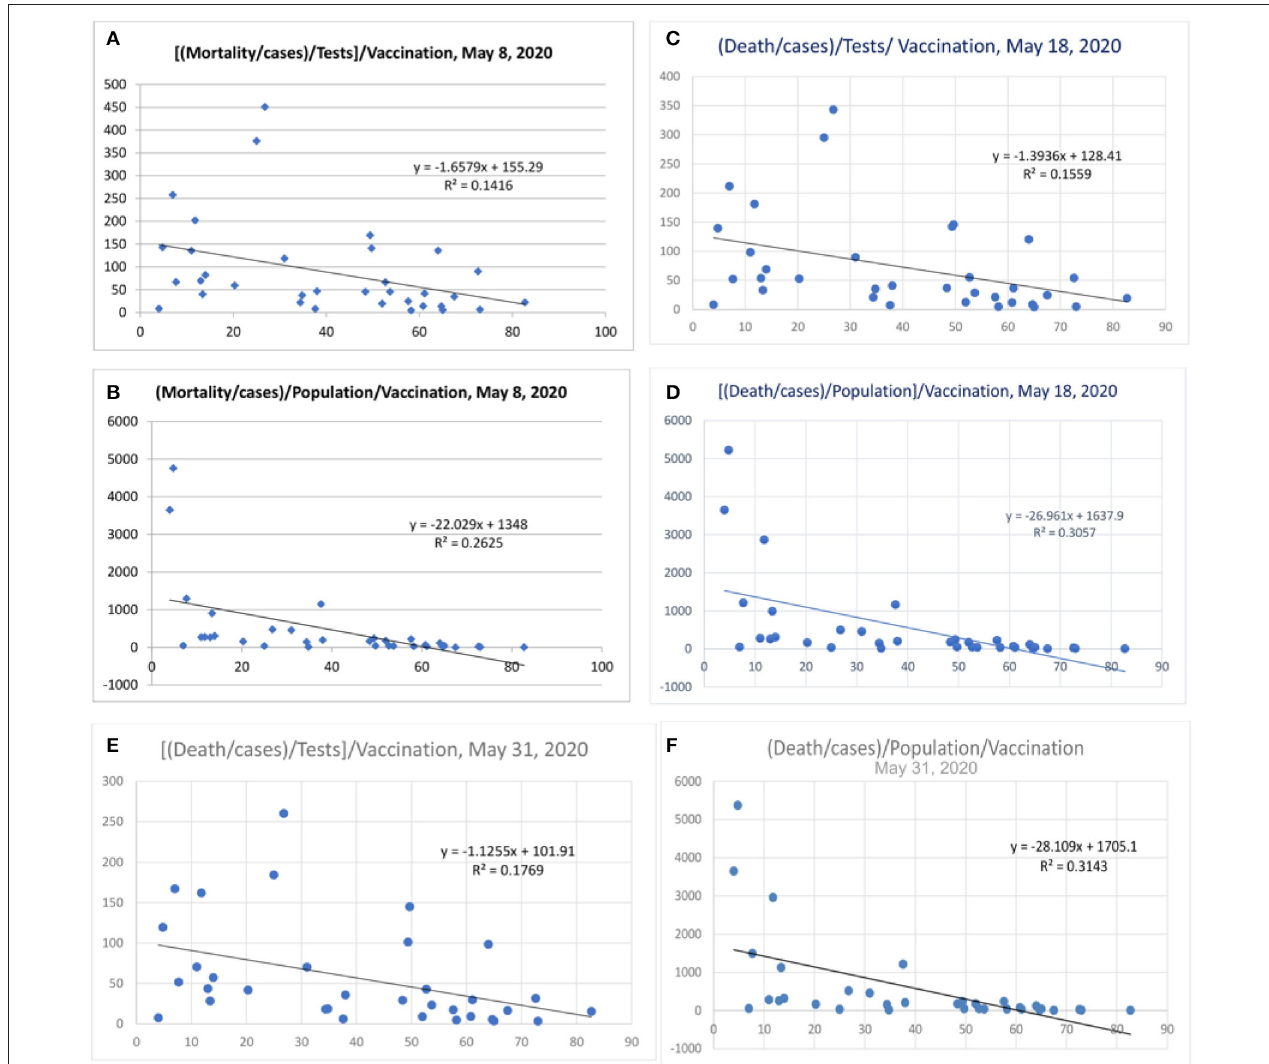
FIGURE 6 | Mortality/Cases adjusted to tests by denominator (A,C,E) . Mortality/cases values adjusted to population in (B,D,F) .